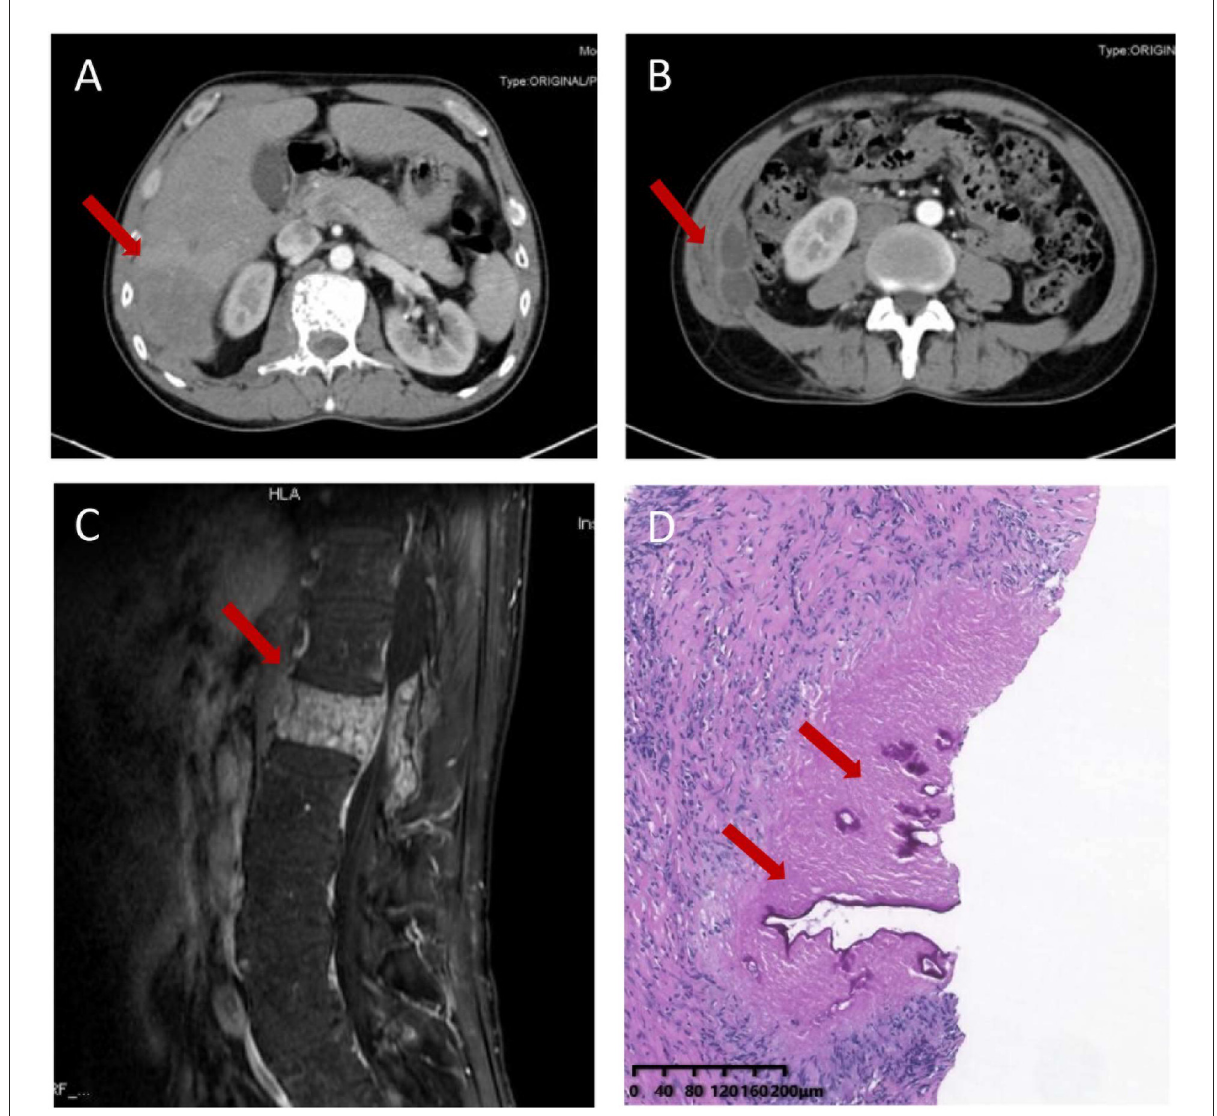
FIGURE1 Imaging and pathological characteristics of the patient. Abdominal computerized tomography (CT) revealed a hypodense lesion with uneven enhancement in the right posterior lobe of the liver (6.5 × 4.6cm) (A) and two ring-enhancing cystic lesions in the right abdominal wall (B) . Enhanced MRI of the thoracic and lumbar spine shows a mixed density lesion with uneven enhancement in the L1 vertebra and paraspinal tissue (C) . Liver biopsy sample showing granulomatous inflammation with necrosis and lamellar structure with positive periodic acid-Schiff positive staining (D)